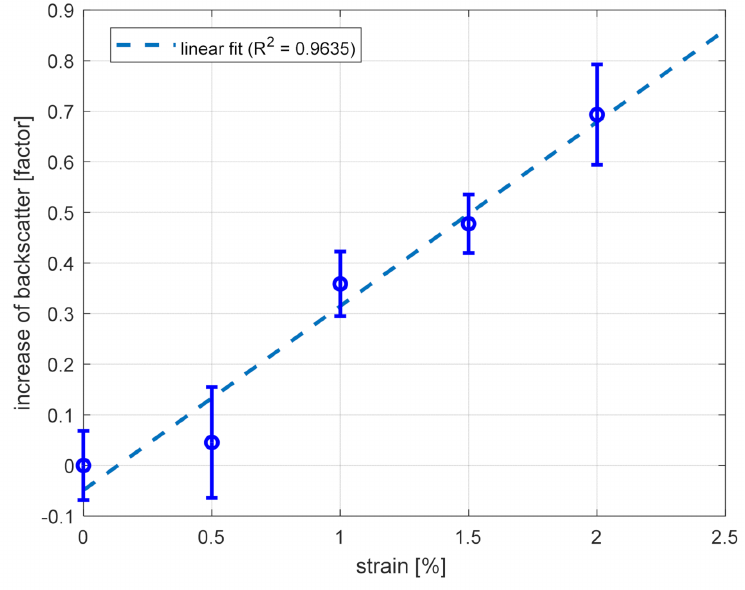
Figure 6. Response of the GI-POF to static strain (squares), and linear fitting curve, as determined during combined strain and vibration measurements. The error bars represent the standard deviation over 5 consecutive